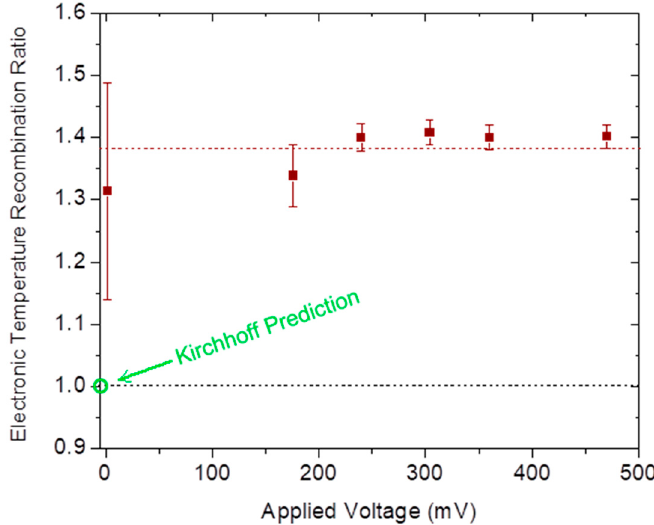
Figure 10. Temperature Ratios at 201 °C. This shows the ratio of spectrum temperature to junction temperature at 201 °C. Note also that at zero bias, the emission spectrum temperature should be the same temperature as the device.